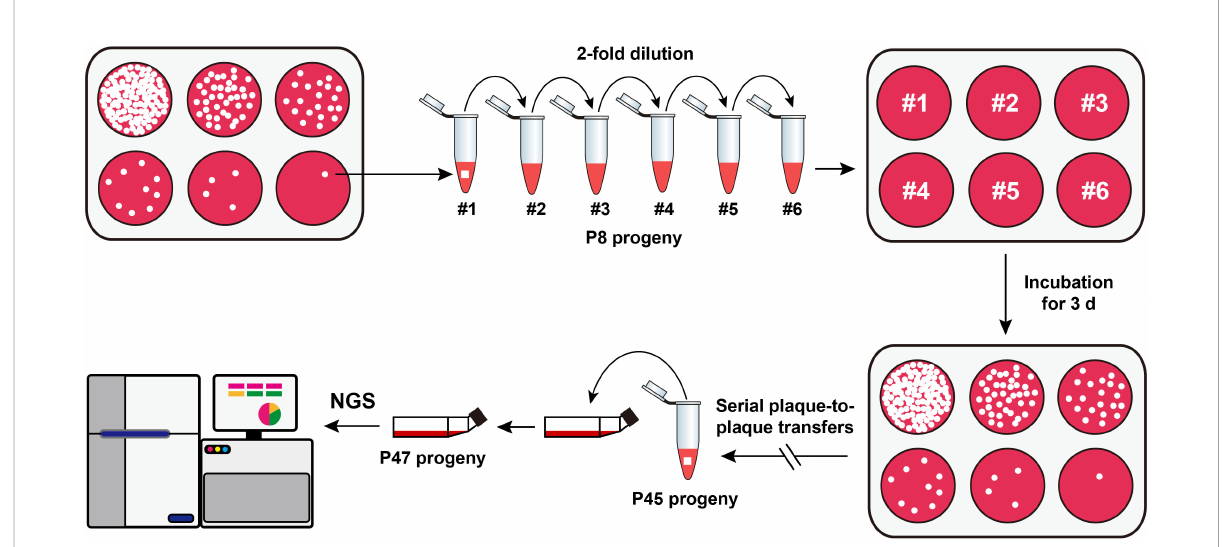
FIGURE 1 Schematic representation of serial viral passaging for NGS analysis. The P7 rCDV-eGFP is subjected to 38 consecutive plaque-to-plaque transfers (P8 to P45) and two extra common passages (P46 and P47) in vitro . The P47 viral stock is harvested for NGS